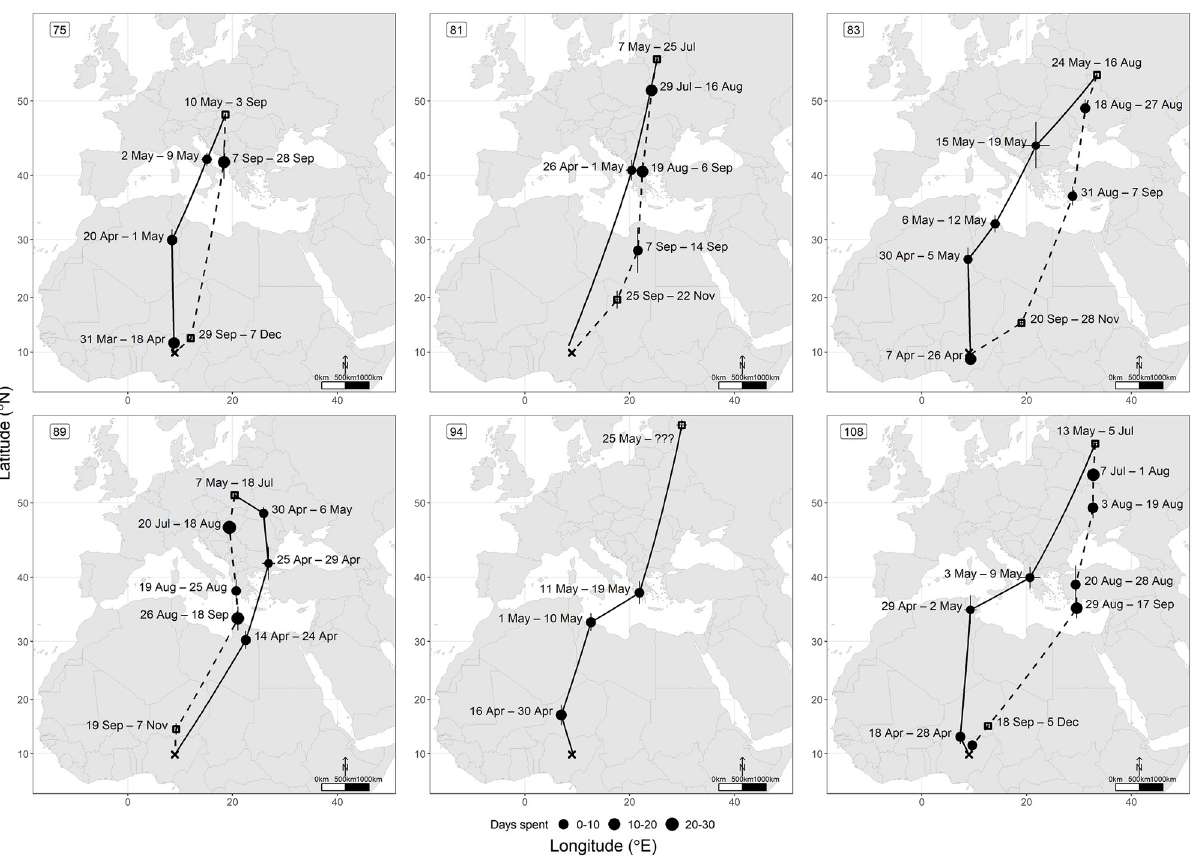
Fig 1. Estimated individual migratory routes. Stopovers are marked as circles and their size represents duration (days) spent at them. Squares represent breeding sites in Europe and first wintering sites in Africa. Sites are shown with standard errors plotted as black asymmetrical crosses. APLORI, in central Nigeria, is marked with a cross. Continuous lines represent spring migration and dashed lines autumn migration. We used the most direct route when connecting locations, so these may not represent exact routes. Numbers in the upper left corners reflect individual